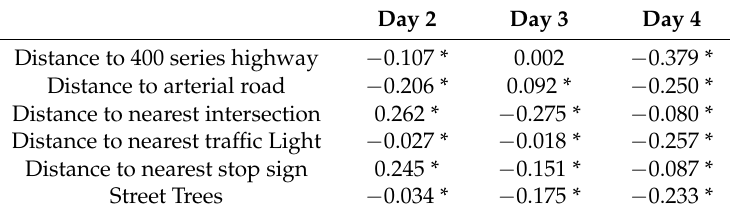
Table 6. Urban form related predictor variables for PM 2.5 exposure analyzed using Pearson’s R .